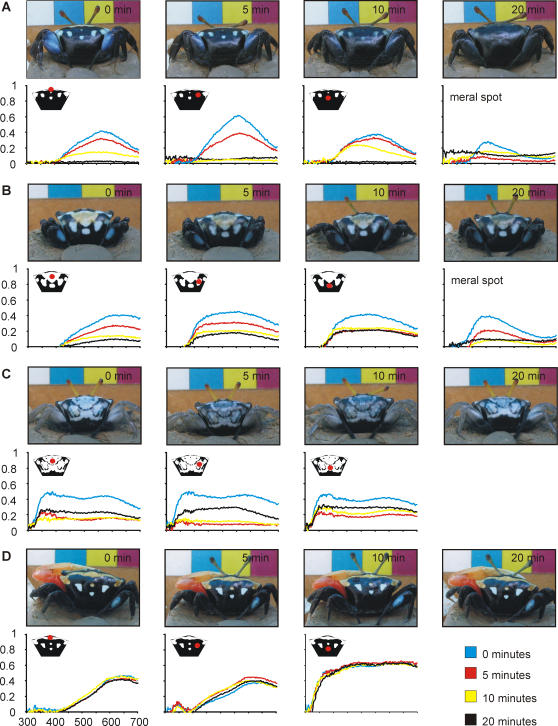
Rapid colour changes in Uca capricornis in response to capture.Each graph corresponds to the spectral reflectance of the area indicated in red on the stylised carapace. Measurements were taken at 0 (blue), 5 (red), 10 (yellow) and 20 (black) minutes after capture. Most individuals steadily darkened their entire colour pattern (a), while in others the yellow scarf region and blue meral spots were more likely to darken (b). Some began to regain their colour within the 20 minutes (c). A small number of crabs, particularly males, did not change colour over 20 minutes (d).